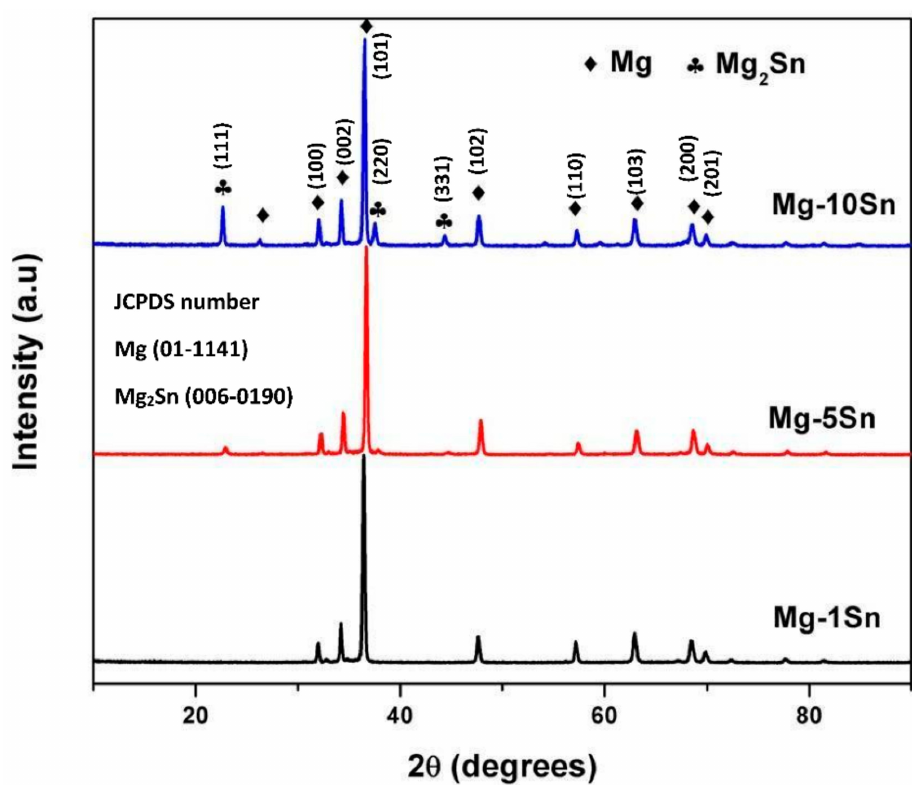
Figure 1. XRD spectra of Mg-Sn